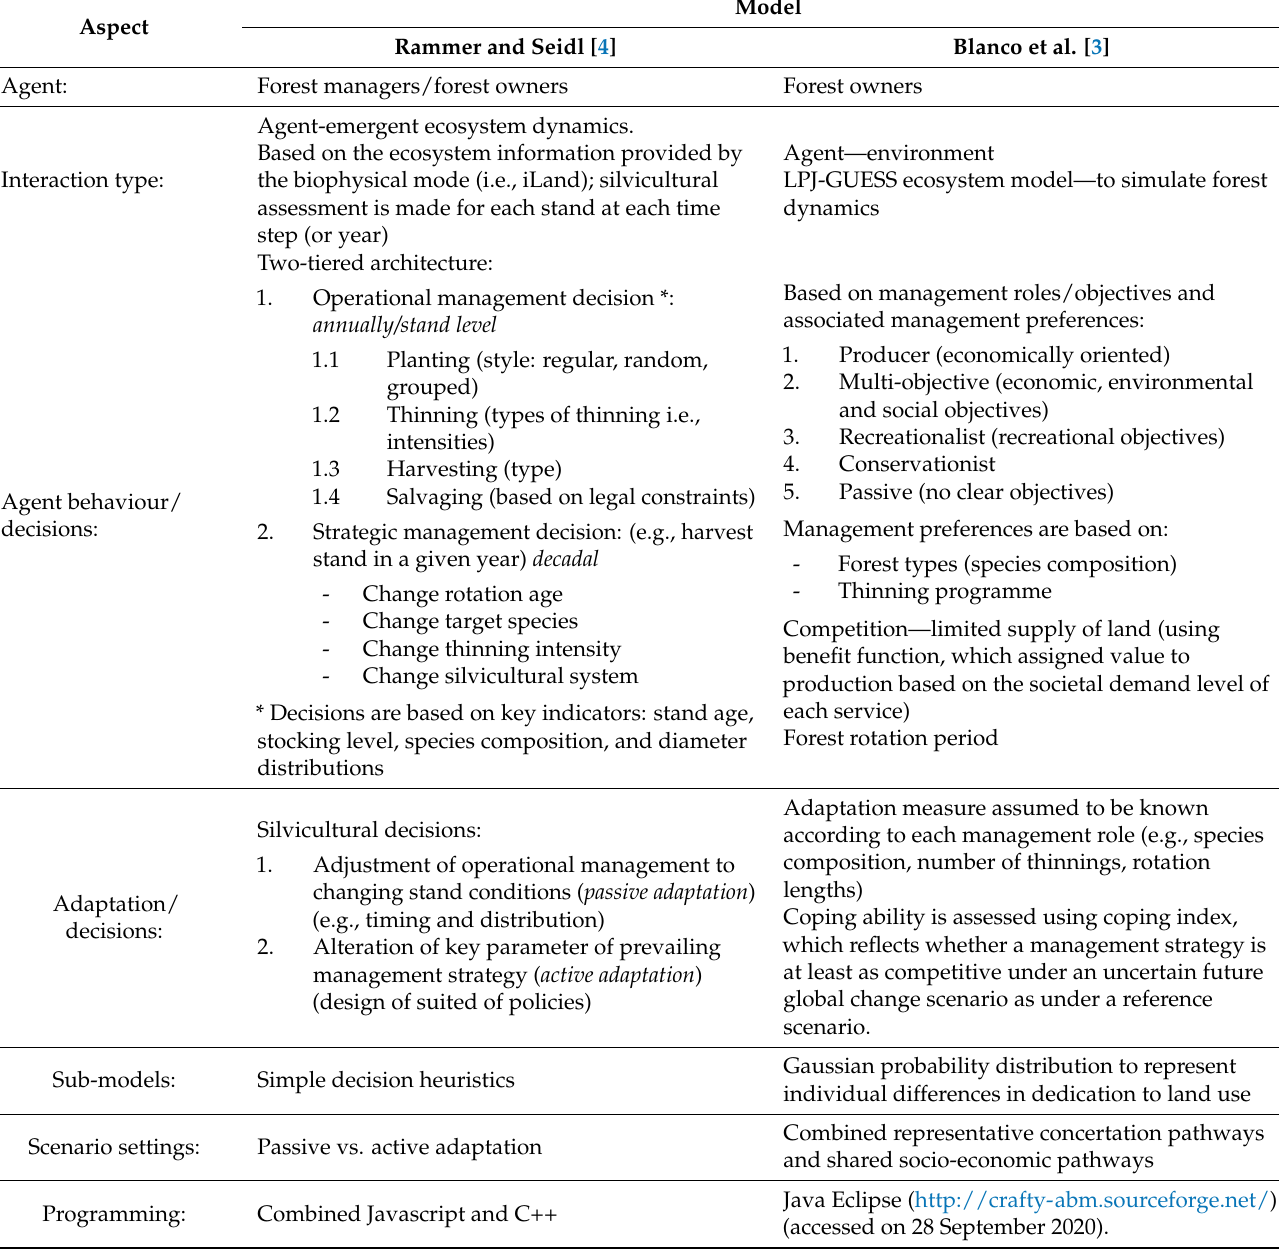
Table 2. Examples of incorporating adaptation decisions in agent-based models for the forestry sector. Model Rammer and Seidl [4] Blanco et al.